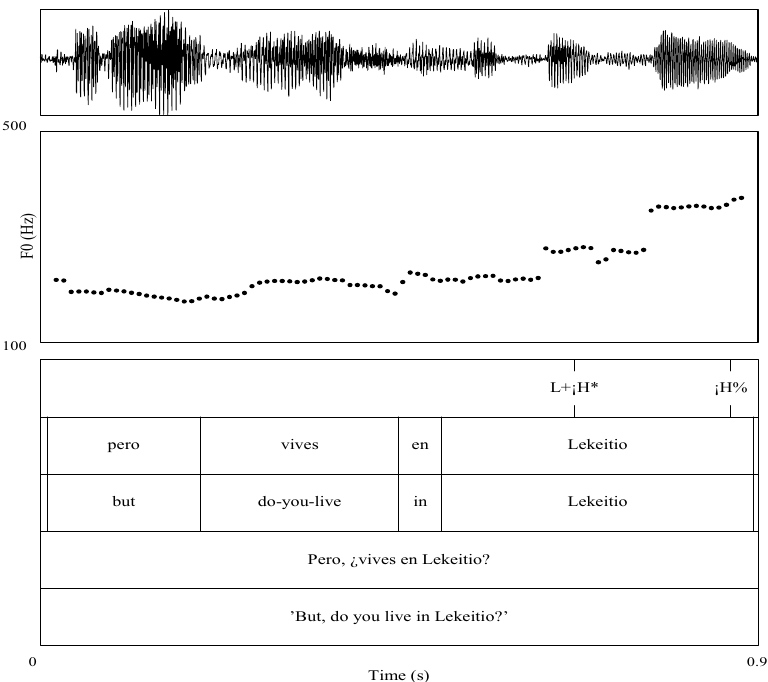
Figure 5. F0 contour of an absolute interrogative statement in Basque Spanish by a female L1 Spanish/L2 Basque speaker from Lekeitio.